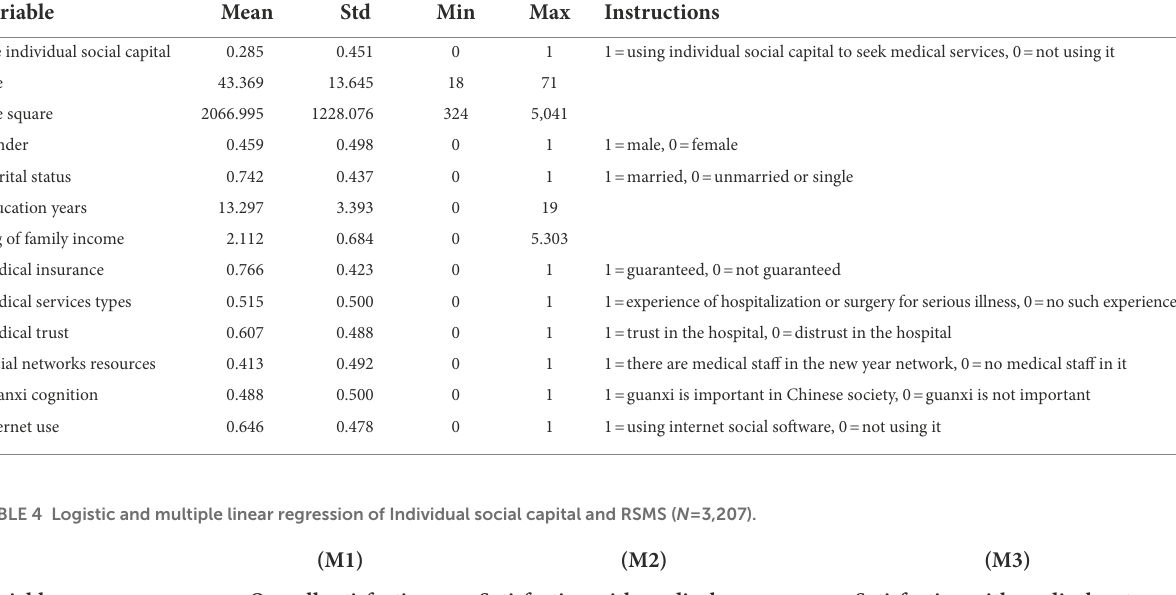
TABLE 3 Variable descriptive statistics ( N = 3,207).